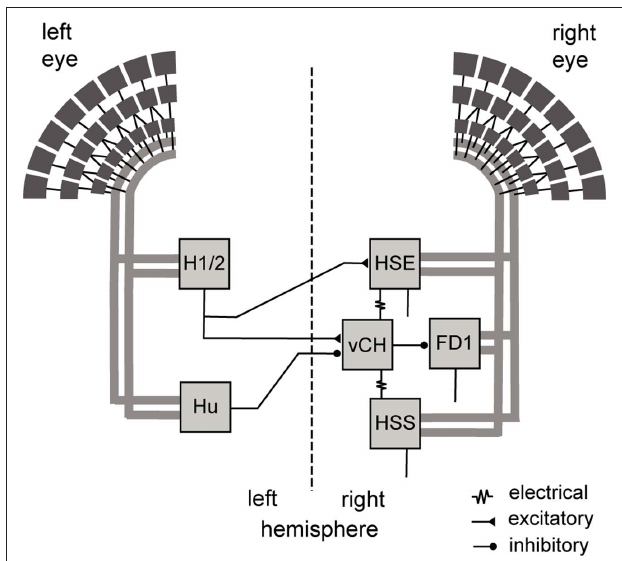
Figure 1 | Wiring sketch of the vCH-cell input circuit. Shown are those motion-sensitive input elements of the vCH-cell that have a horizontal preferred direction, as well as the postsynaptic FD1-cell. All input elements of the vCH-cell get retinotopic motion input (thick gray lines) from large portions of one eye. The H1 and H2 of the left brain hemisphere excite the vCH-cell of the right hemisphere, whereas the left Hu-cell inhibits it. The HSE-cell and the HSS-cell of the right side are electrically coupled to the vCH-cell, which inhibits the